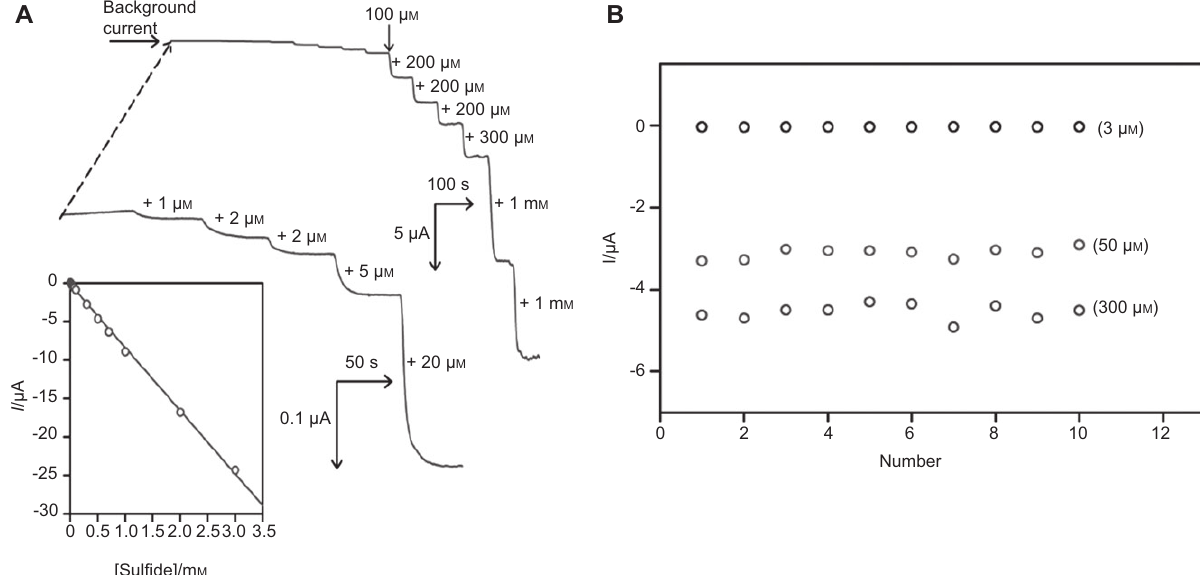
Figure 3 (A) Chronoamperometric response of sulfide at the FeCN-PIL-SPCE in pH 7, 0.1 m PBS at a detection potential of 0.0 V versus Ag/AgCl. The insert graph is the calibration curve with a linear concentration range of 1 μ m to 3 m m ; and (B) the results at the FeCN-PIL-SPCE for 10 continuous additions of 3 μ m , 50 μ m and 300 μ m sulfide, respectively.